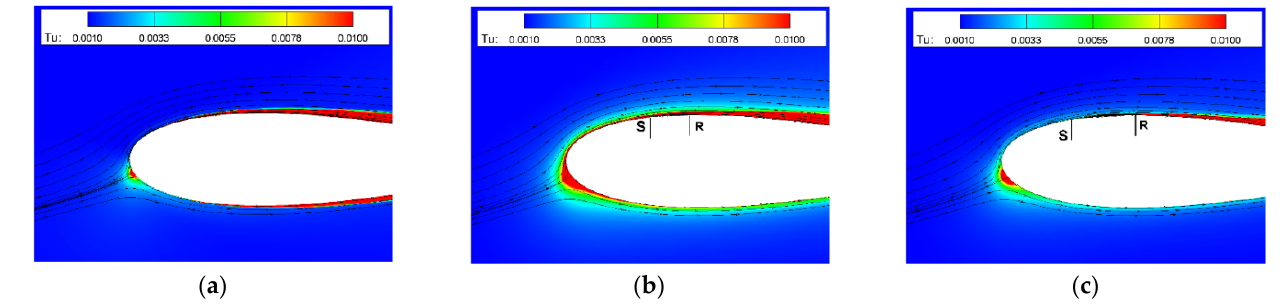
Figure 3. Computed turbulence intensity distribution and streamlines at α = 8°. ( a ) SST-2003. ( b ) γ -Re θ t SST. ( c ) γ -Re θ t SST-2003.(“S” denotes separation point and “R” denotes reattachment point.)